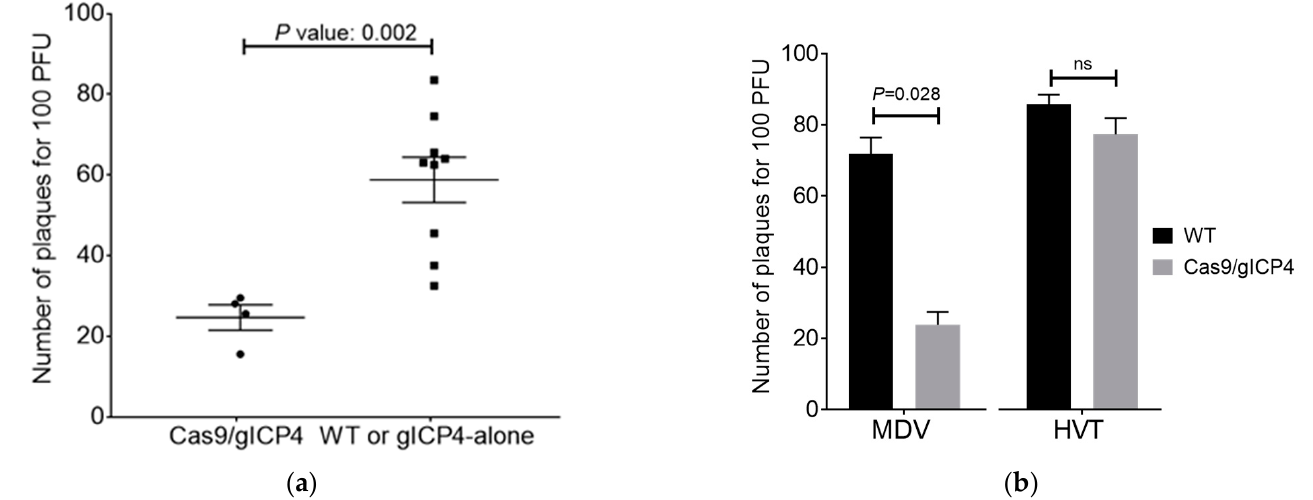
Figure 4. Specific inhibition of MDV and not herpesvirus of turkeys (HVT) in transgenic CEF. ( a ) Individual CEF cultures, Test (4 Cas9/gICP4) and control (total 9 CEF; 8 WT and 1 gRNA alone), were infected with 100 PFU of MDV Woodland (p19). Plaque numbers were calculated at 5 days post-infection (dpi). Error bars correspond to standard error of the mean (SEM). Statistical difference was calculated using a two-tailed Mann–Whitney test. p value indicates the level of significance between two groups. ( b ) The effect of the serotype 1-specific ICP4-gRNAs and Cas9 on MDV. CEF were prepared from WT (black bars) or Cas9/gICP4 (grey bars) embryos and plated at 2 × 10 6 cells per well in a six-well plate. Triplicate cultures were infected with 100 PFU of serotype 1 MDV Woodland (p19) or serotype 3 HVT vaccine. The plaques were counted at 5 dpi. Values are shown as the mean of four replicates. Error bars correspond to SEM. p value indicates the level of significance between two groups. ns denotes not significant.